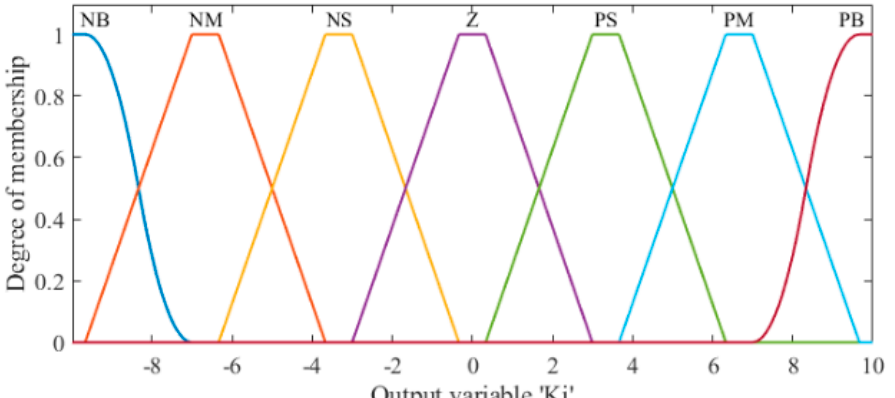
Figure 5. Membership functions of K (cid:2919) .